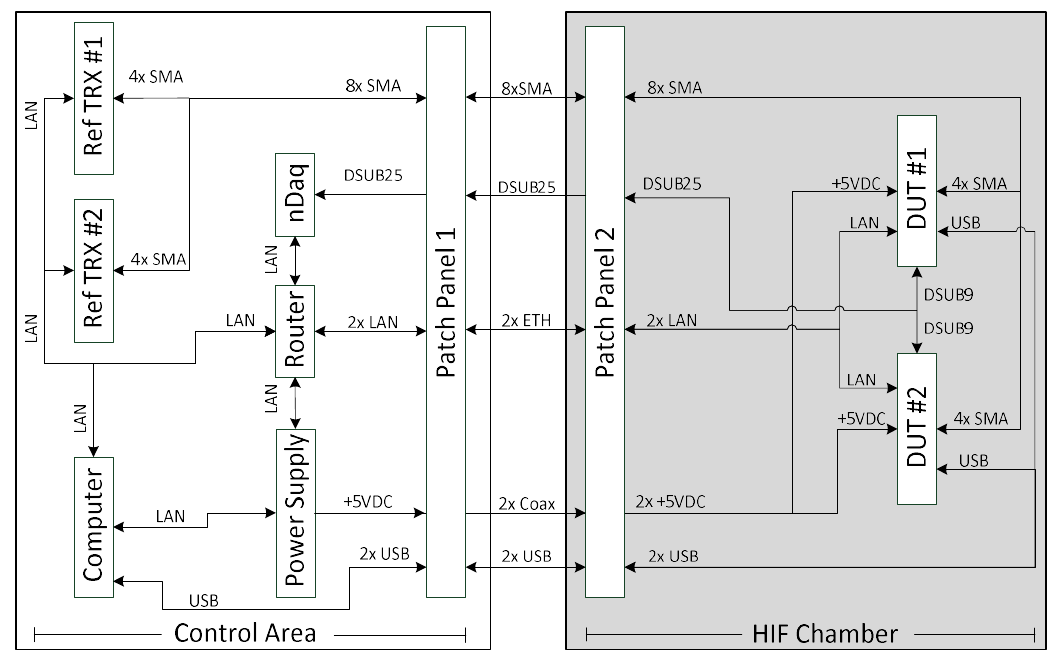
Figure 6. Heavy Ion test setup schematic at UCL/HIF.